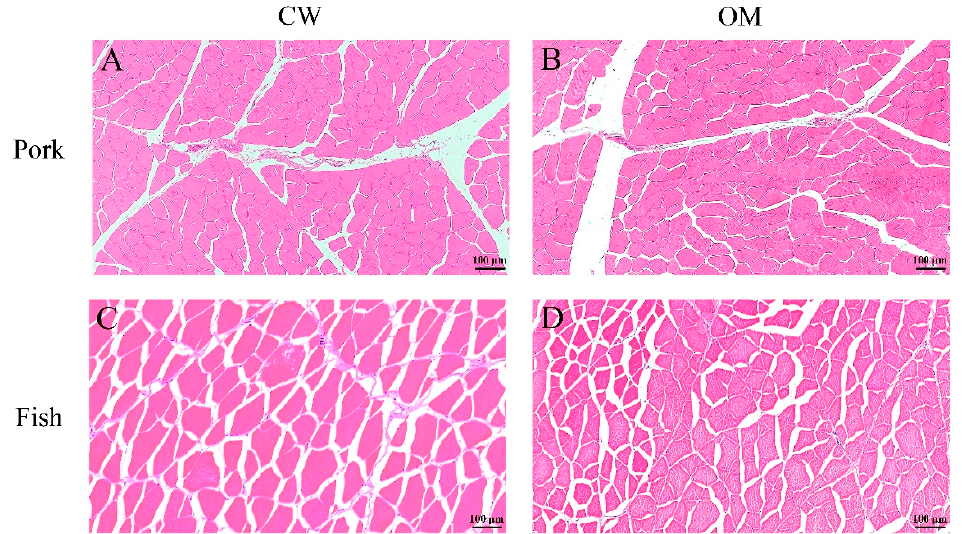
Figure 1. Effects of different washing treatments on the microstructure of muscle tissue. CW: conventional water-washing; OM: ozone-microbubble-washing. Pork samples treated with CM ( A ) and OM ( B ); fish treated with CW ( C ) and OM ( D ).